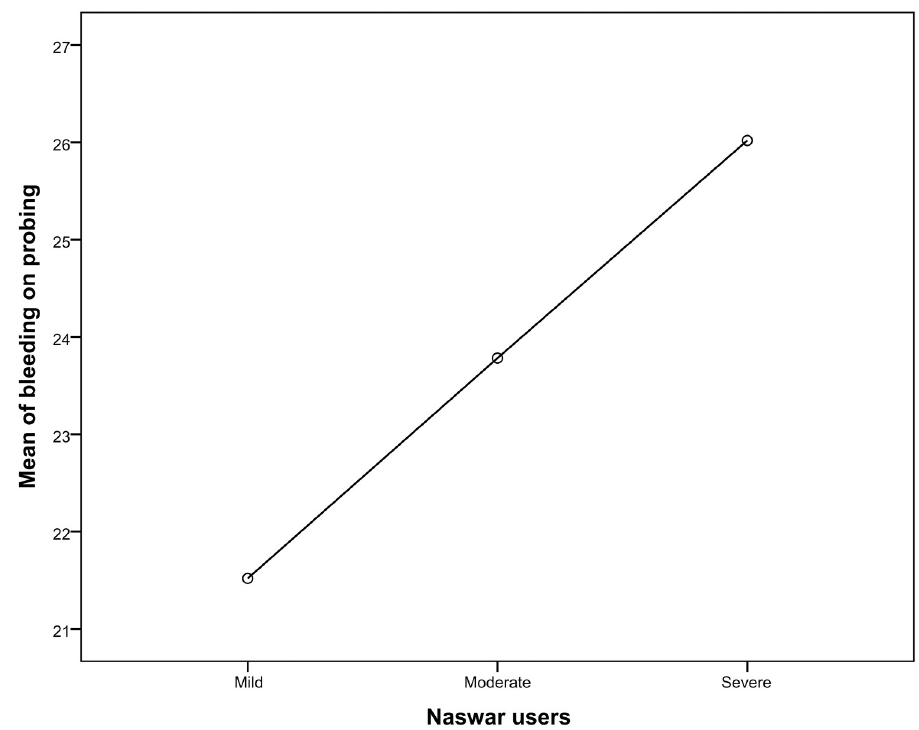
Fig 2. Mean score of bleeding on probing (BOP).